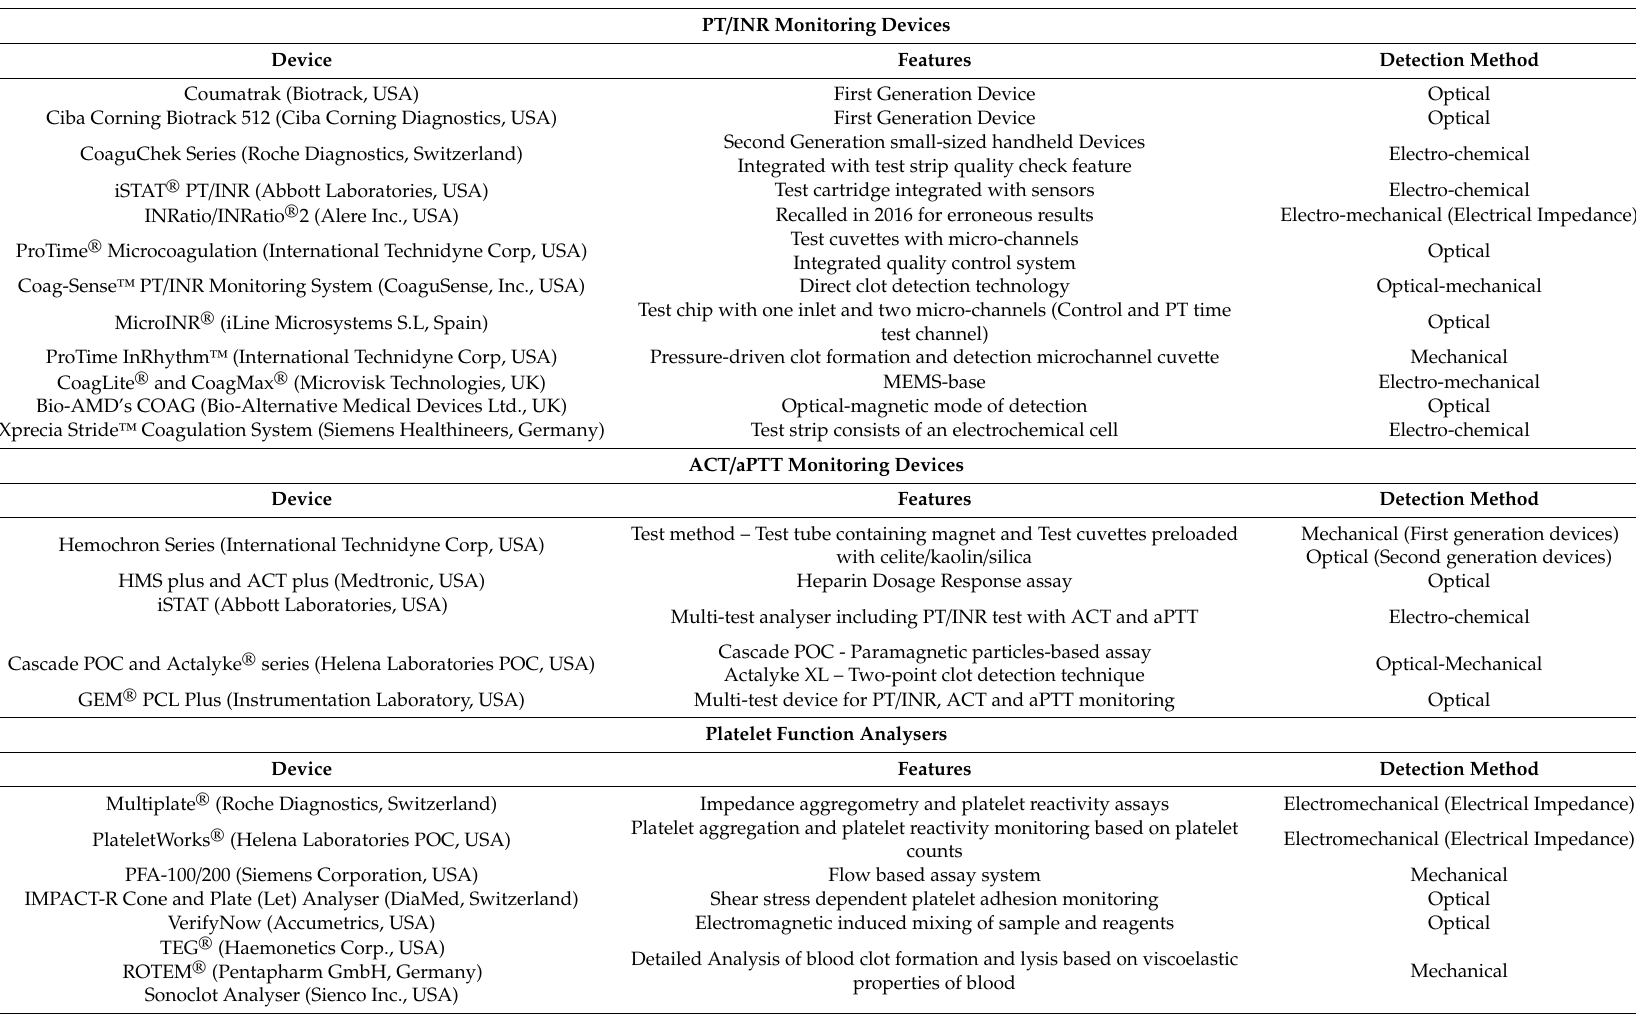
Table 1. Features detection methods and for a selection of commercially available coagulation monitoring